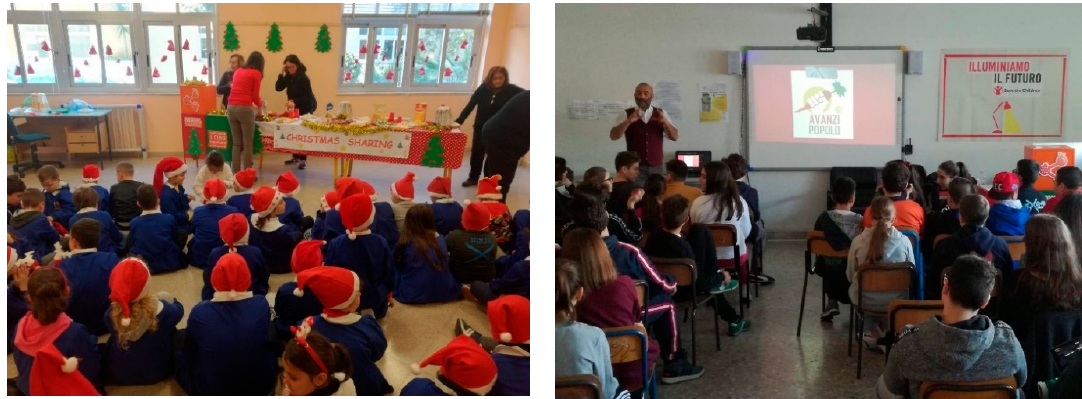
Figure 3. Educational activity about Food Waste (FW) reduction. Source: Avanzi Popolo 2.0.